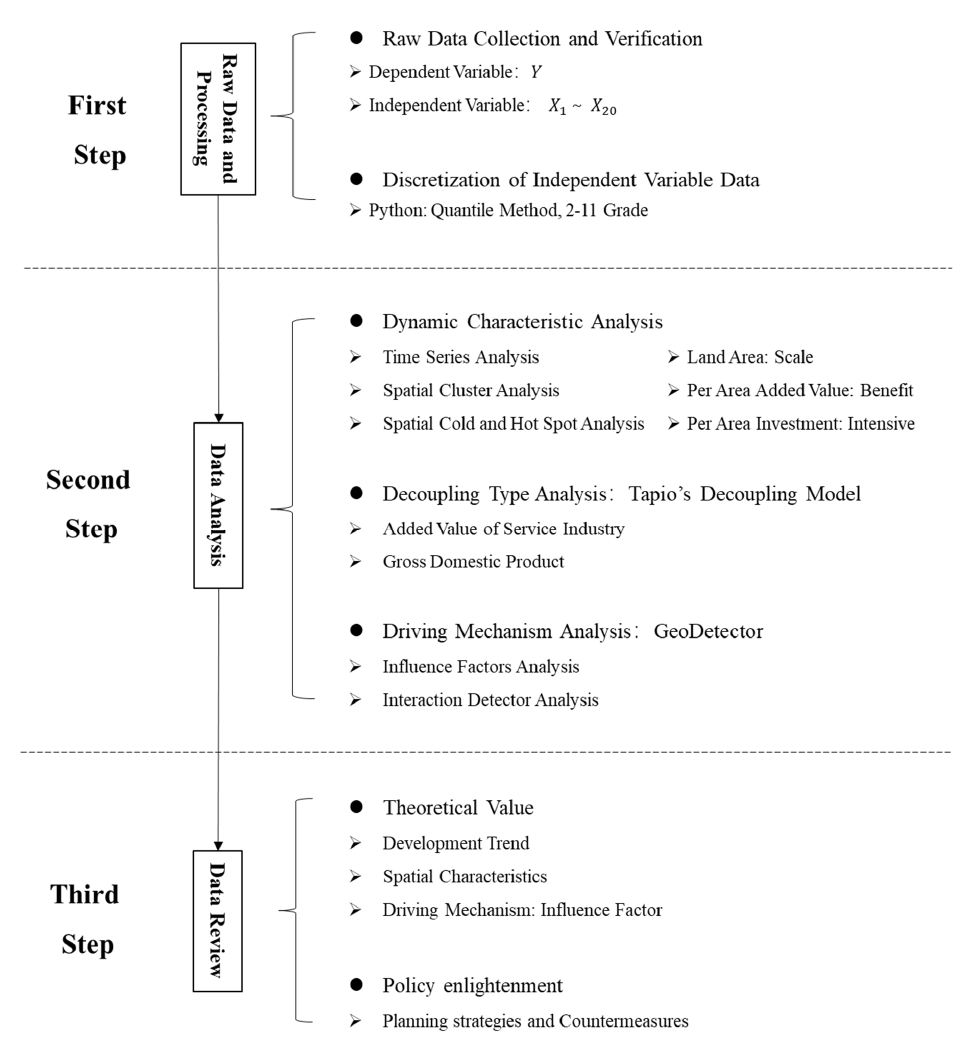
Figure 6. Research